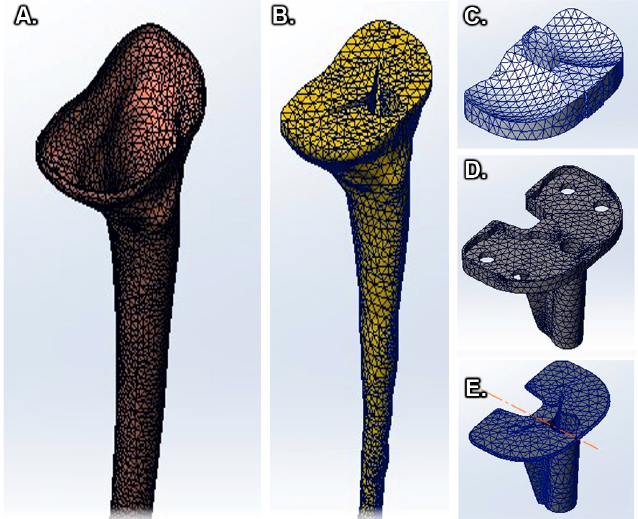
Figure 5. Tibial bone–implant model: ( A ) cortical bone, ( B ) cancellous bone, ( C ) polyethylene insert, ( D ) tibial tray, and ( E ) cement mantle. To simulate the in vivo behavior of the implant, the tibial bone–knee implant assem- bly was created (Figure 6).